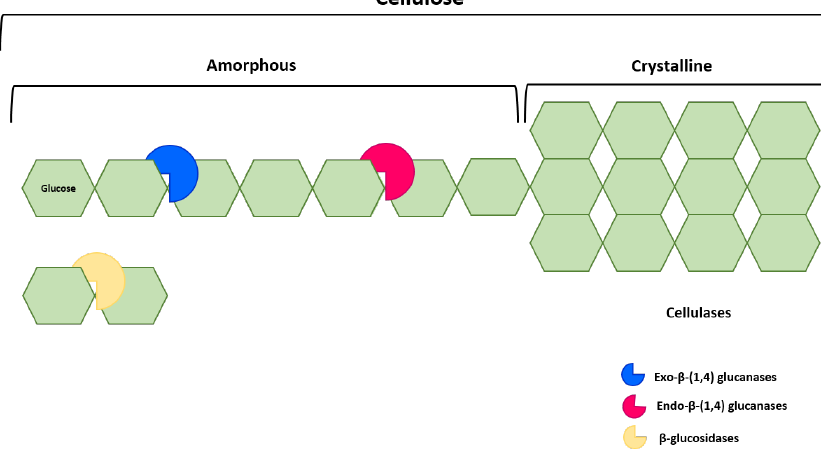
Figure 2. Mechanism of degradation of cellulose via hydrolytic enzymes. Zhang et al. [126] tested enzyme-assisted extraction of lipids from Scenedesmus sp . fresh biomass using cellulase, xylanase, and pectinase. Their results in terms of recovery of lipids and fatty acid methyl esters (FAMEs) were ca. 2-fold those of the enzyme-free control group. Enzymatic pretreatment led to hydrolysis of polysaccharides into short- chain oligosaccharides and/or monosaccharides. To compare untreated and enzymatically treated Scenedesmus sp., the content of the cell wall in main organic carbon groups was analyzed. Results showed that the ratio of bonds C C/C H and ether bonds C O in un- treated and enzymatically treated microalgae is 3.33 and 4.56, respectively, thus account- ing for ca. 90% of the total organic carbon groups in the cell wall. As described in section 1.3, the algal cell wall contains a polysaccharide specific matrix and glycoproteins. Reduc- tion of ether groups therein was attributed to hydrolyses of β-glucosidic linkages by en- zymes [127]; hence, the absolute content of bonds C C/C H remained stable. Enzymatic hydrolysis using cellulase was tested by Cho et al. [128] upon C. vulgar- ism —who observed an enhancement in lipid extraction by 1.73-fold relative to unhydro- lyzed cultures. Snailase and trypsin have been claimed as enzymes able to provide higher yields of oil recovery (ca. 35%) in comparison to cellulase (16%), neutral protease (12%), or alkaline protease (8%) [129]. On the other hand, Cheng et al. [130] obtained lower ex- traction yields with snailase (7%), again upon C. vulgaris. Enzymatic pretreatment of the sugars present in microalgal biomass offers many ad- vantages over e.g., chemical hydrolysis with acids or alkalis. Since this method does not require expensive equipment, neither does it generate toxic products [72], it appears as a promising approach in attempts to improve lipid extraction from microalgae. 2.6. Acid Hydrolysis Strong acids, such as hydrochloric, sulfuric, or nitric, are commonly used in this pre- treatment—even though several factors, such as acid strength, duration of treatment, and temperature, considerably affect the yield of acid hydrolysis, depending on the microalgal species at stake [131]. From a literature search, acid hydrolysis has proven a simple and effective method to extract lipids from wet biomass. It mainly targets release of bound lipids by weakening lipid-starch and -protein intermolecular forces [132] and is therefore required for extrac- tion of otherwise bound lipids. This technique minimizes disturbances caused by the wa- ter phase, being more effective than physical or thermal methods; evidence in this regard